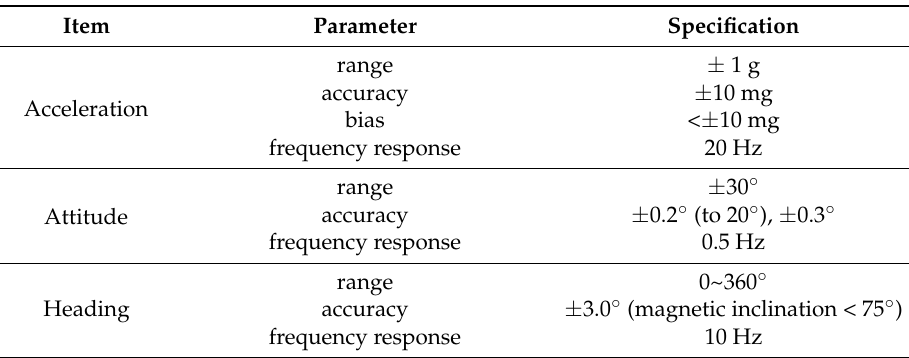
Table 1. ATC wave sensor